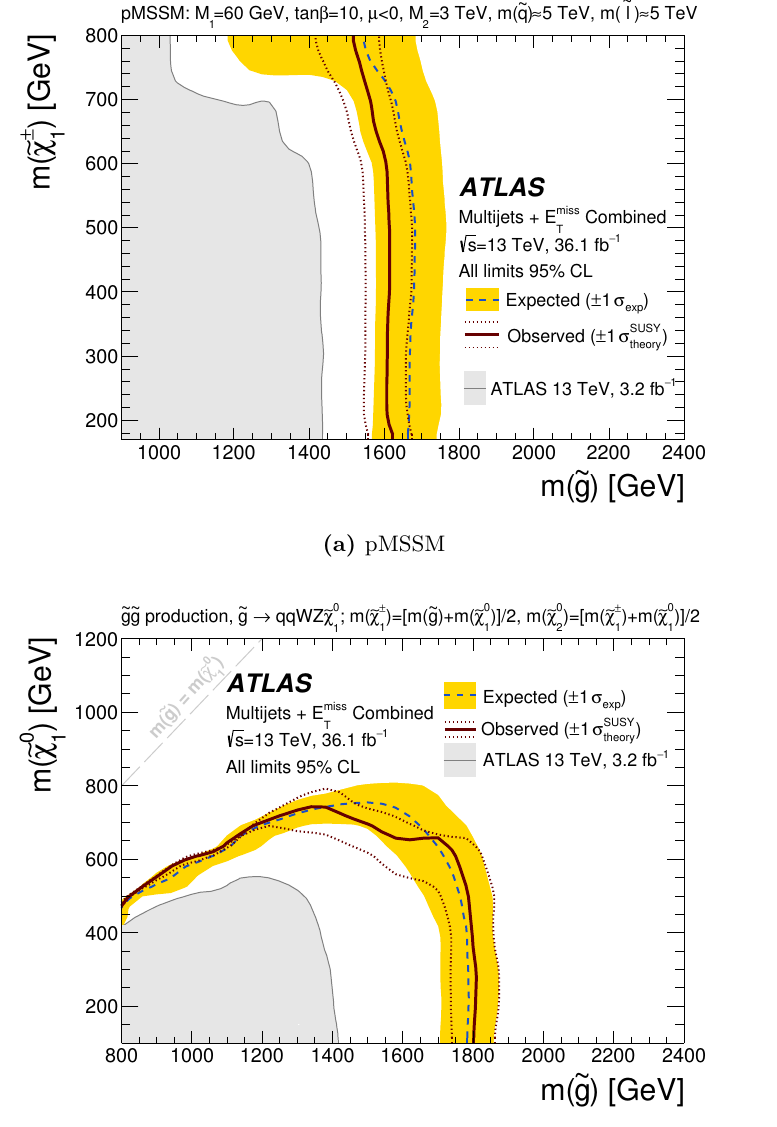
Figure 6. Exclusion contours in the m plane for the pMSSM (a) and the m ~ g ; m plane ~ g ; m ~ (cid:31) (cid:6) ~ (cid:31) 0 1 1 in a simpli(cid:12)ed model with the gluino decaying via a two-step cascade (b). The solid maroon line indicates the observed limit, while the dashed blue line shows the expected limit. Experimental, MC theoretical and statistical uncertainties are shown in the yellow band. Dotted maroon lines delimit the variation of the observed limit within the (cid:6) 1 (cid:27) uncertainties in the signal cross-section at NLO+NLL